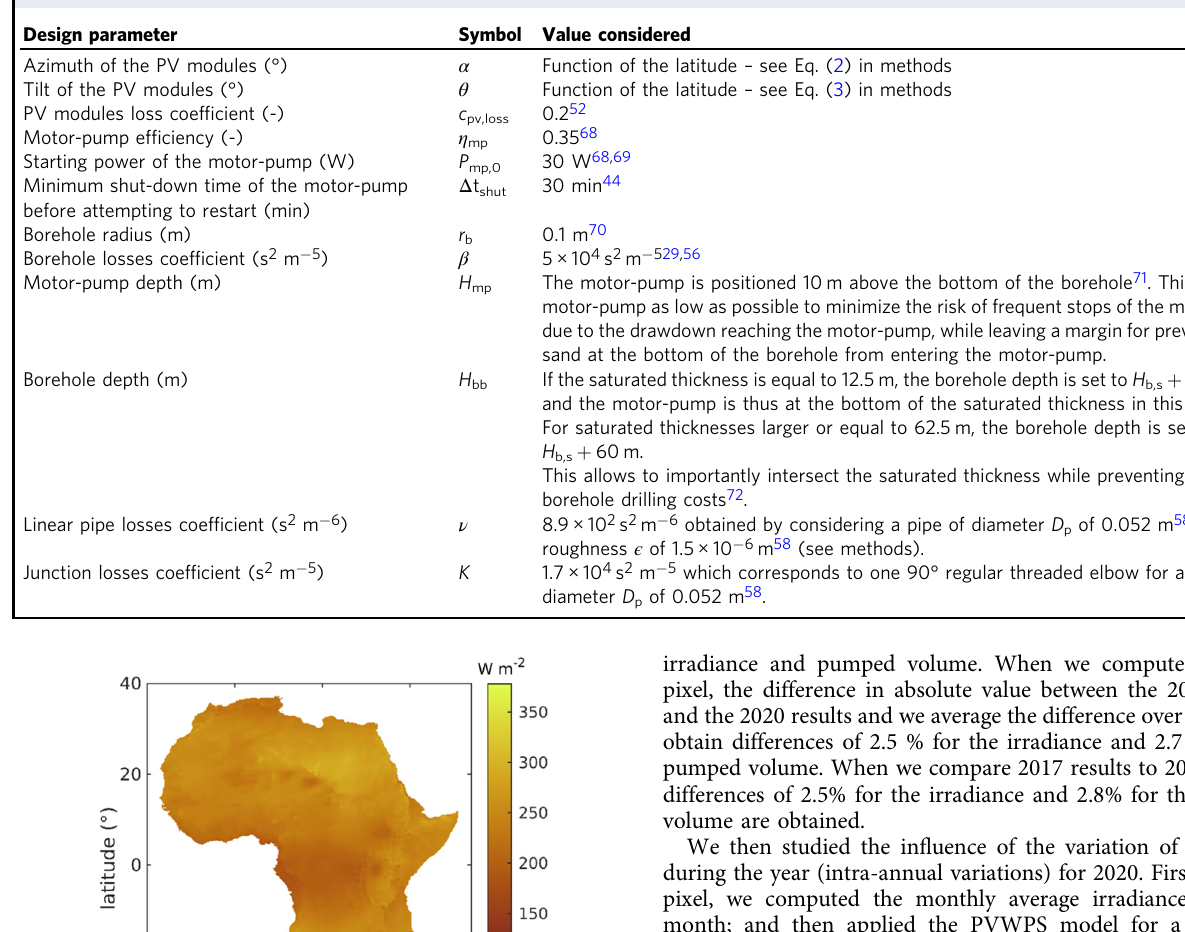
Table 2 Values considered for the design parameters.